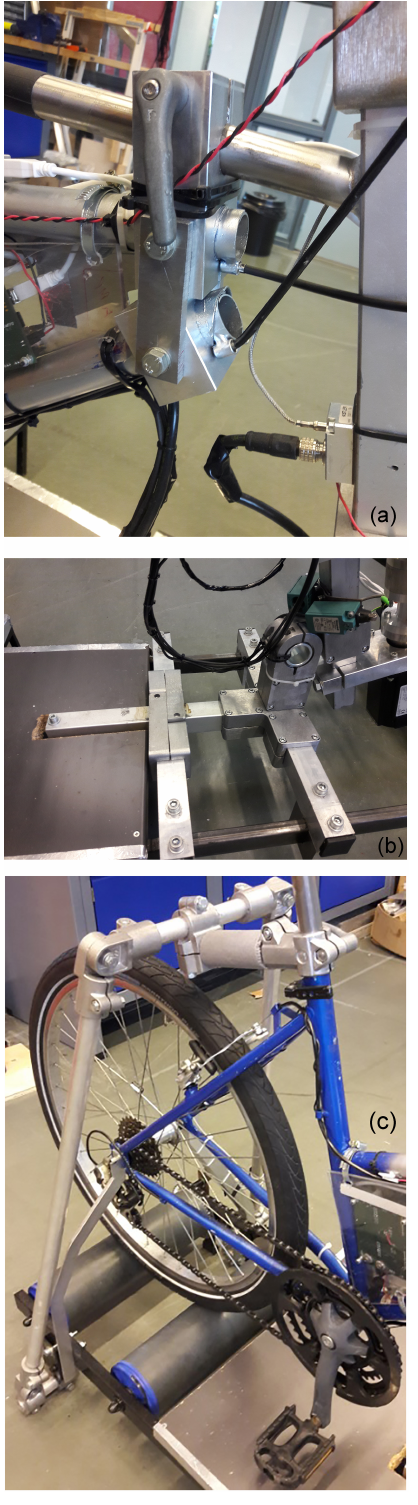
Figure 3. Connection of the bicycle frame to the roller base using prismatic joints and mechanical arms.